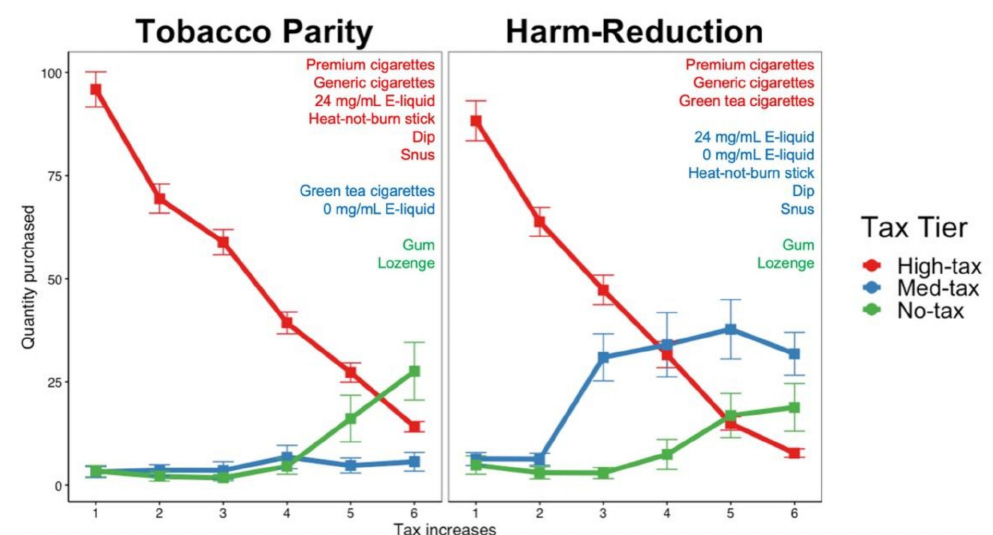
Figure 2. Total quantity of products purchased in the high, medium, and no tax tiers across trials in the tobacco parity and harm reduction tax